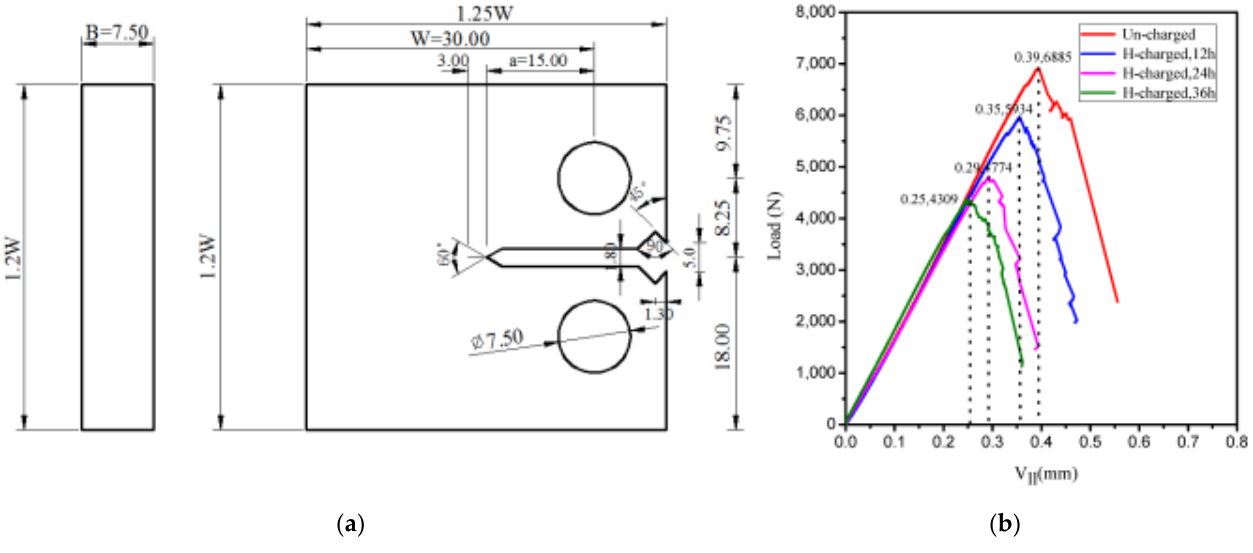
Figure 2. ( a ) Geometry of CT specimen (unit: mm); ( b ) load-line displacement curves for CT specimen.